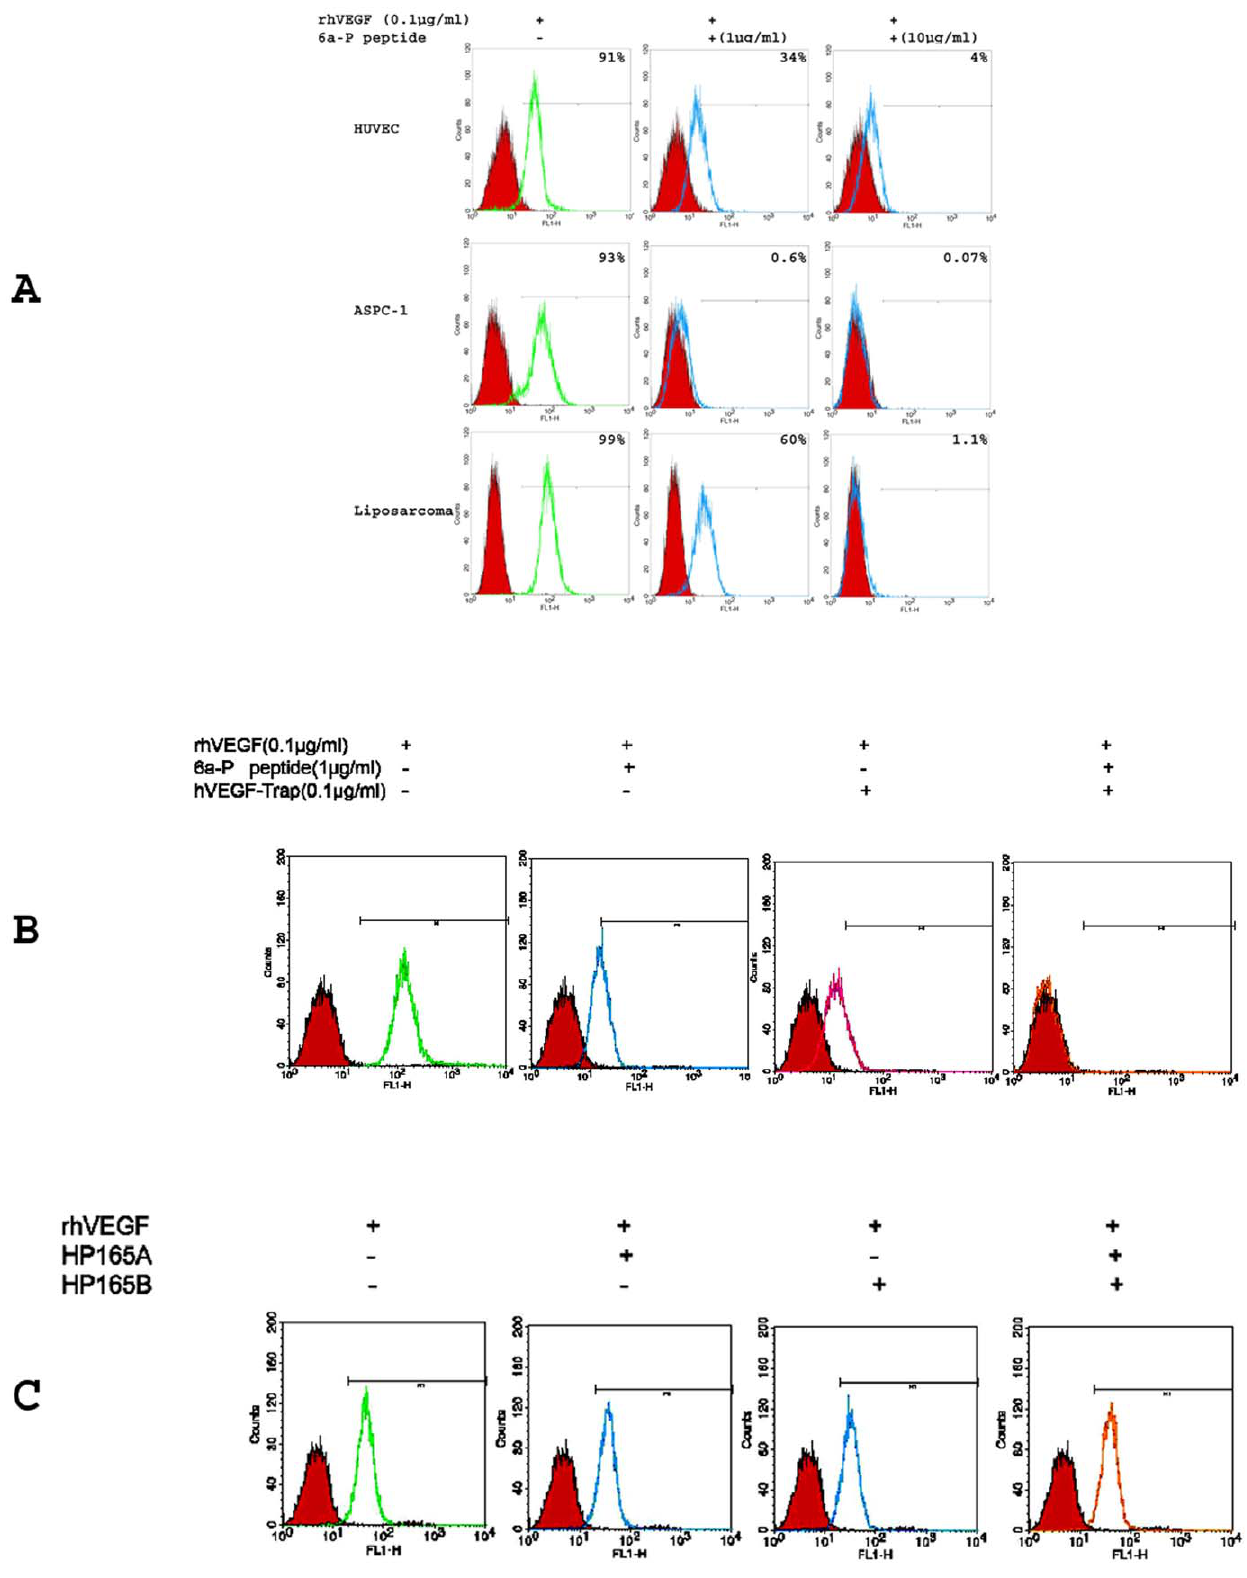
Figure 1. 6a-P peptide prevents VEGF binding to different cell types by FACS analysis . HUVECs, fibroblasts, AsPC-1 and liposarcoma cells were subjected to FACS analysis. Cells were digested and resuspensed with 2% BSA in PBS for blocking, 0.1 m g/ml rhVEGF was incubated and present or absent with 1 (low dose) or 10 (high dose) m g/ml of the peptide for 1 h in 4 u C. After cold PBS washing, the samples were incubated with VEGF antibody and secondary FITC-labeled antibody. The results show that rhVEGF binding activity is inhibited when the peptide is present (A). VEGF-Trap